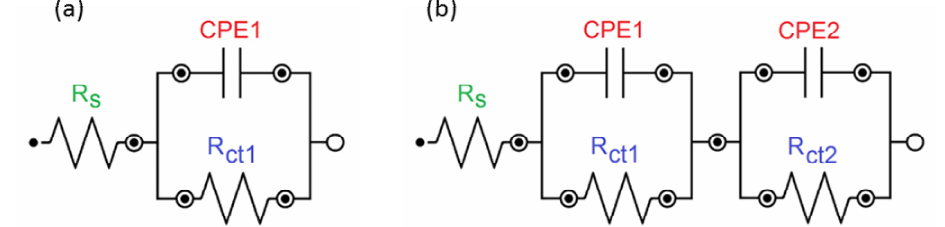
Figure 11. Equivalent electrical circuit for the NiTi|oxide layer|Ringer solution system ( a ) and the NiTi|oxide layer|composite HAp/nSiO 2 /Ag coating|Ringer solution system ( b ) in the pitting corrosion